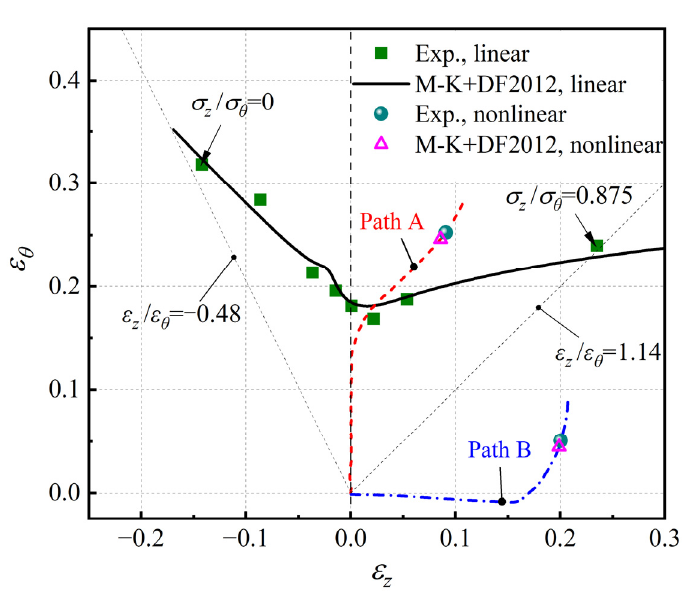
Figure 9. Comparison of the predicted and experimental limit strains of the AA6061 tube.